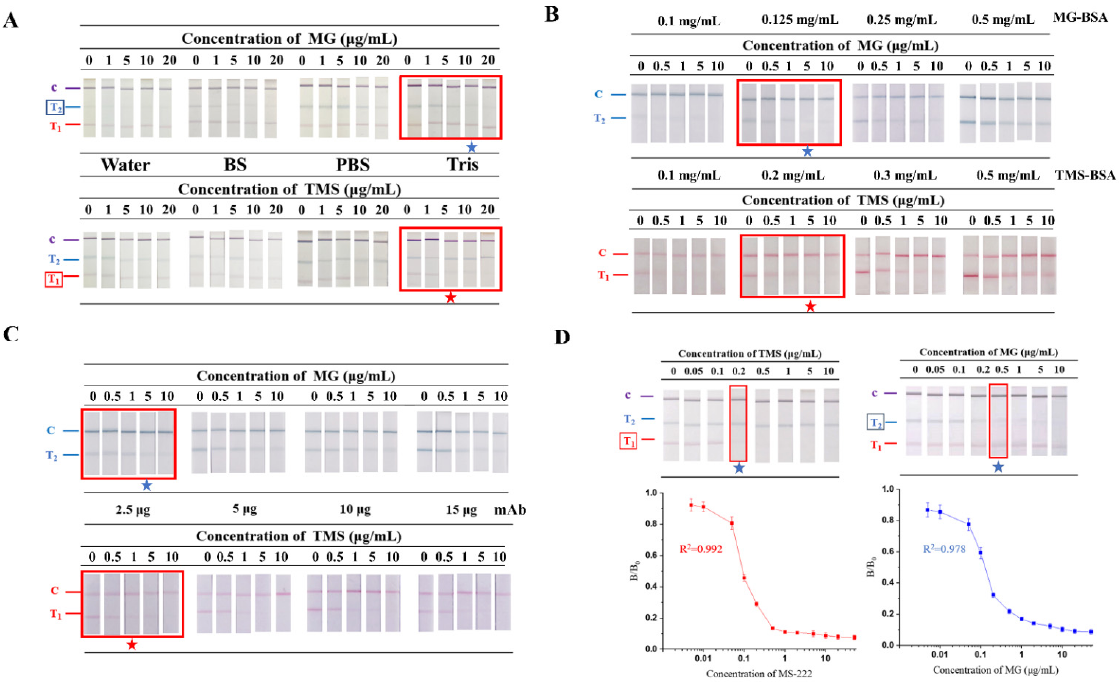
Figure 2. Optimisation results of different conditions. ( A ) Loading buffer solution. ( B ) Concentration of coating antigens of TMS-BSA and MG-BSA. ( C ) The amount of mAbs used to prepare AuNP probes for TMS and MG. ( D ) Single detection sensitivity of TS-DTL, ( left ) for TMS, ( right ) for MG. Red and blue stars indicate the qualitative limit of TMS and MG, respectively. A fixed concentration of TMS-BSA (0.1, 0.2, 0.3, 0.5 mg/mL) on the T 1 line and MG-BSA (0.1, 0.125, 0.25, 0.5 mg/mL) on the T 2 line were employed to evaluate the optimal antigen coating concentrations. As shown in Figure 2B, with increasing antigen concen- trations of TMS-BSA and MG-BSA, the signal intensities of the double T lines and C line were gradually enhanced. When the coating concentration of TMS-BSA at T 1 was 0.2 mg/mL and the MG-BSA at T 2 was 0.125 mg/mL, both the red T 1 and blue T 2 lines were invisible for 5 μ g/mL TMS and MG. Additionally, the B / B 0 values of TMS and MG were lower than 0.2, indicating that there were strong positive results at this concentration. Hence, 0.2 mg/mL TMS-BSA (0.2 μ g cm − 1 on T 1 line) and 0.125 mg/mL MG-BSA (0.125 μ g cm − 1 on T 1 line) were chosen as the optimum coating concentrations of the T lines. to TMS and MG. As represented in Figure 2C, the colour intensity of the test zones deep-